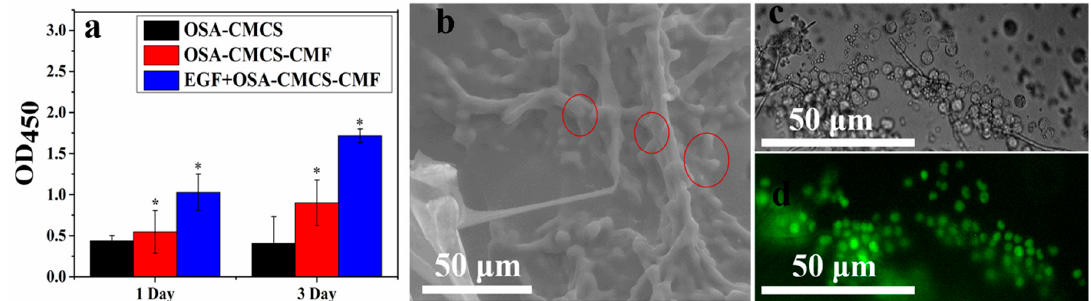
Figure 4. ( a ) Cell growth on different hydrogels after 1 and 3 days of culture (Comparing the data of each group with the OD value of the OSA–CMCS group on the first day, * p < 0.05, there is a significant difference. ( b ) ESEM of cells growing inside the hydrogel. ( c ) Light micrograph of cells growing inside the hydrogel. ( d ) Fluorescence staining of cells growing inside the hydrogel.